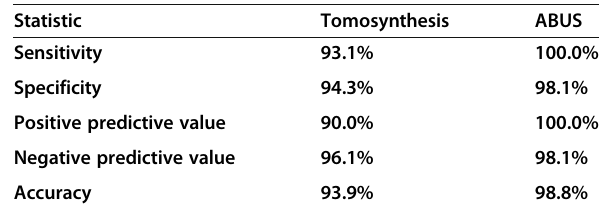
Table 5 Comparison between accuracy measures of tomosynthesis and